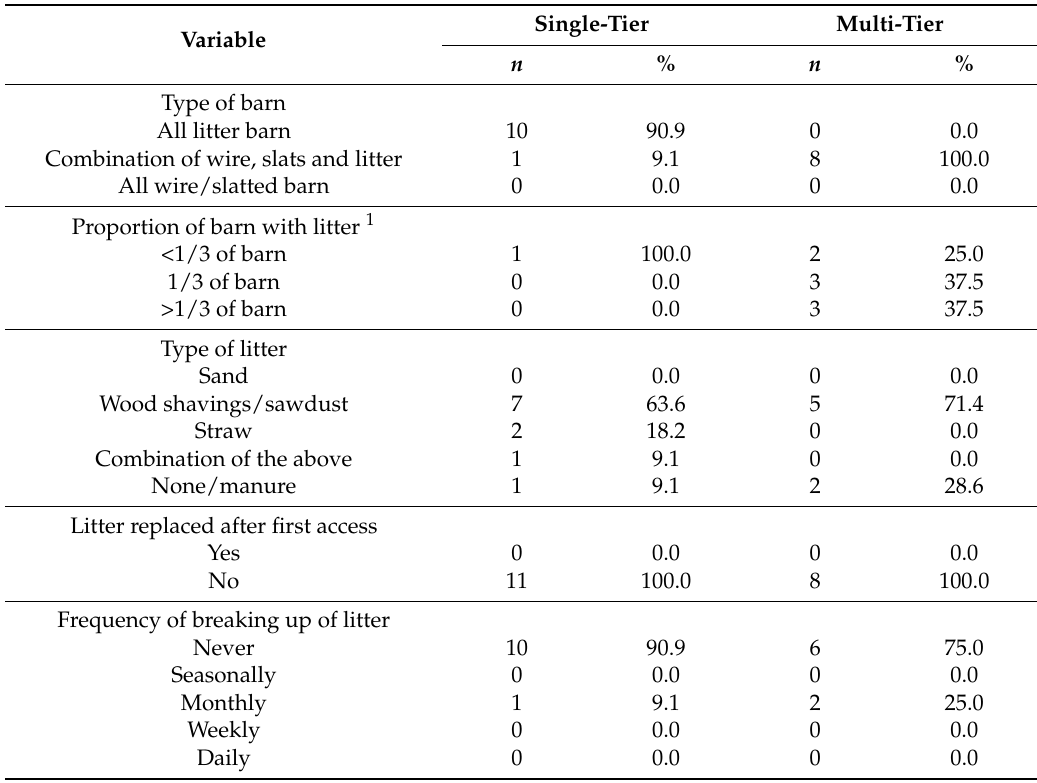
Table 3. Summary of litter management aspects for pullet flocks placed between May and November 2017 according to housing system (single-tier n = 11, multi-tier n = 8) in Canada.